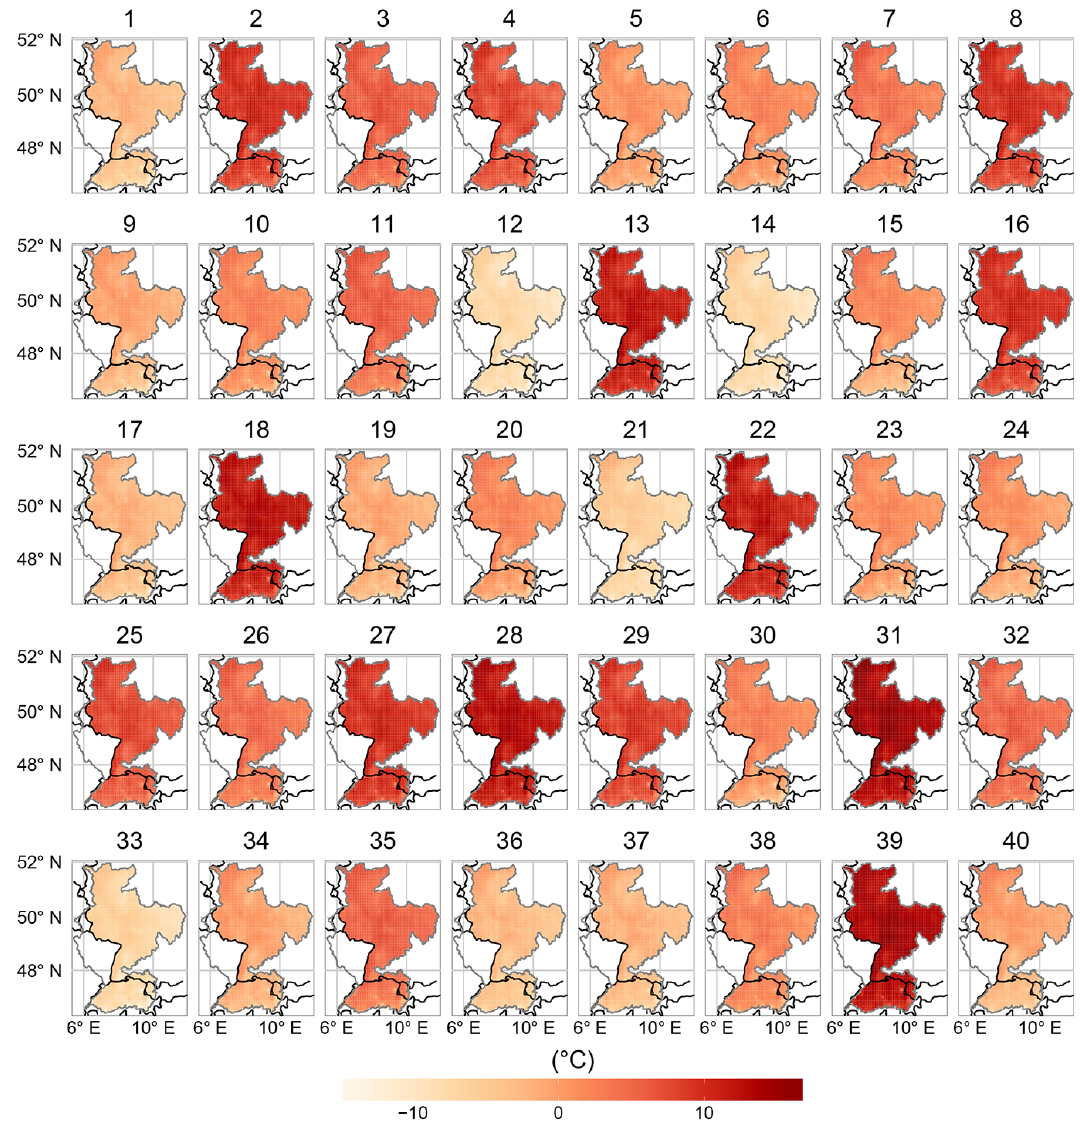
Figure A6. As in Fig. A1 but for daily minimum